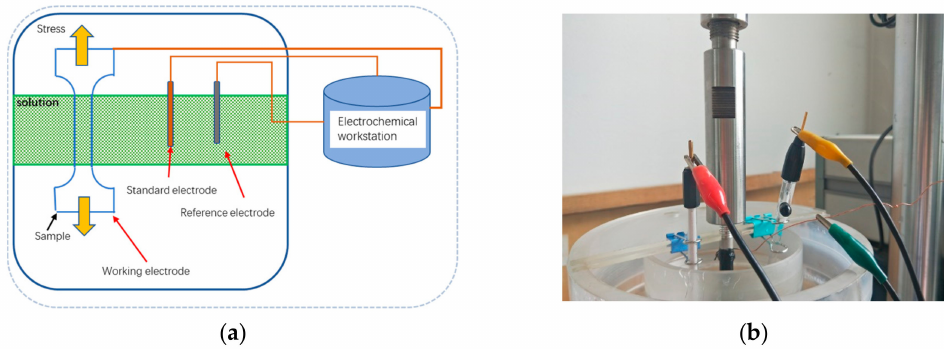
Figure 2. Schematic diagram of electrochemical test method ( a ) and photo of the device ( b